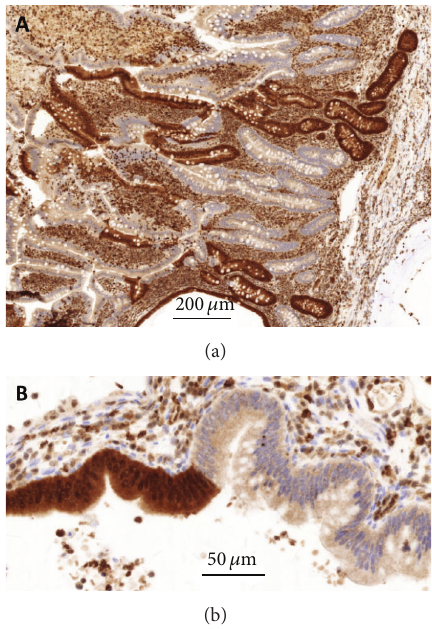
Figure 3: SMAD4 immunohistochemistry. Loss of SMAD4 expres- sion in epithelial cells of the mucosa with retained expression in the stromal compartment. (a) Overview. (b) High power.